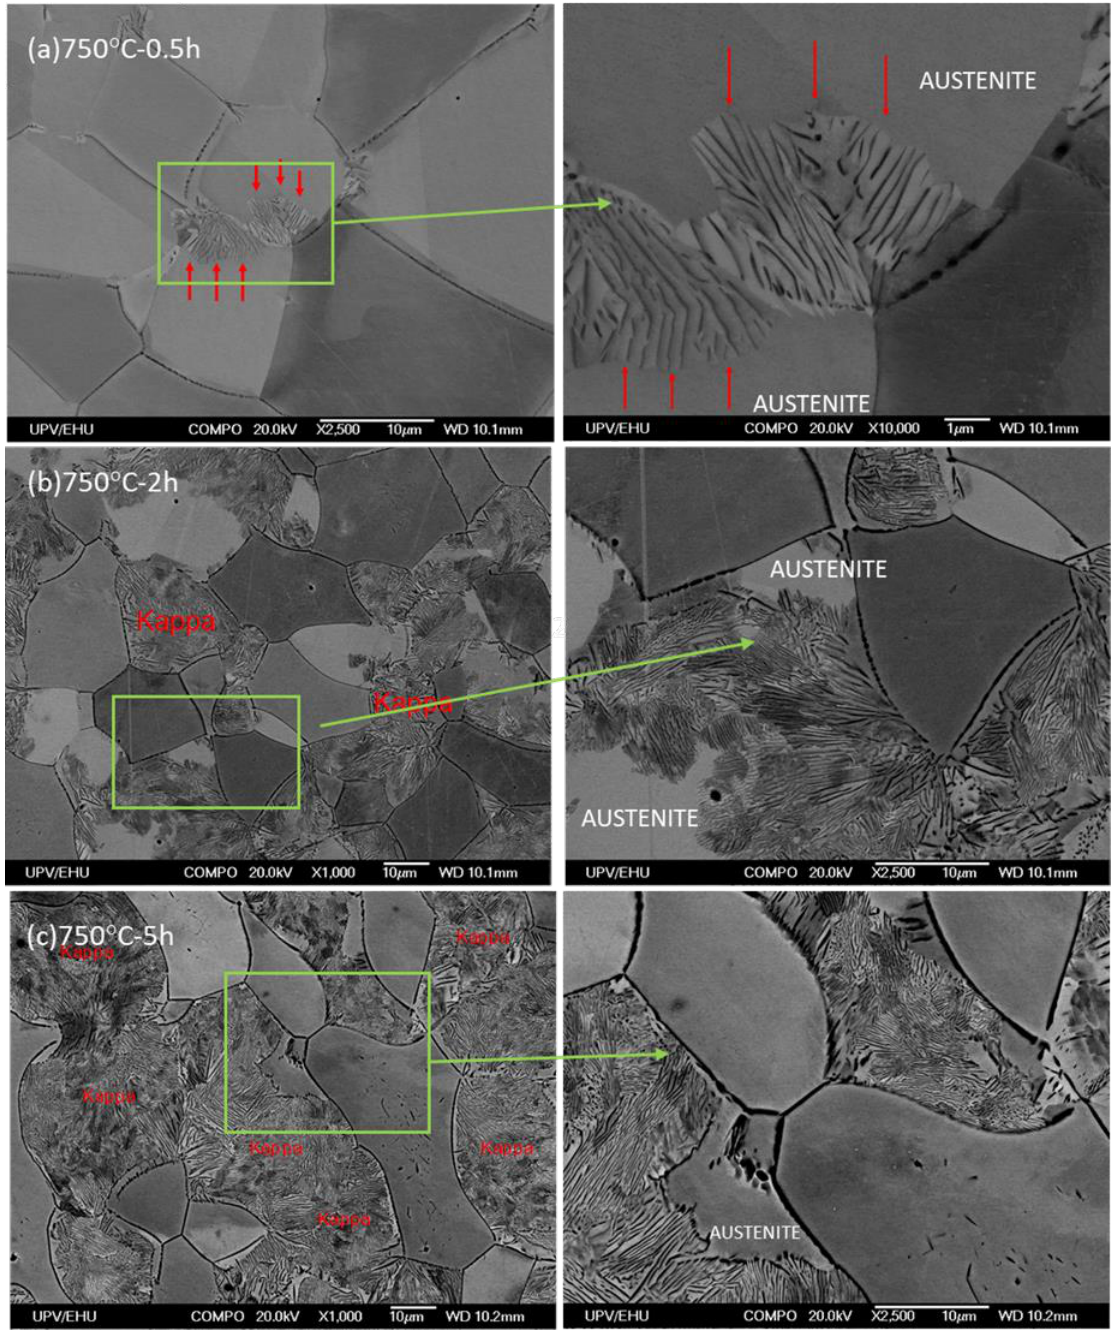
Figure 6. SEM micrographs of the alloy after heat treatments performed at 750 °C for ( a ) 0.5 h, ( b ) 2 h and ( c ) 5 h. In order to study the influence of temperature in the first stages of k-carbide precipita- tion, additional treatments were performed at 700 ◦ C and 650 ◦ C with a holding time of 2 h. Temperatures were selected inside the range predicted by Thermocalc Software for the existence of k-carbides. Figure 7 shows the diffractograms and optical microscope images for the material after these treatments. In Figure 8’s SEM images, tiny precipitates at the austenite-ferrite grain boundaries can be seen growing into the austenite phase at 650 ◦ C. These precipitates are slightly larger at 700 °C and remain undetectable in XRD.